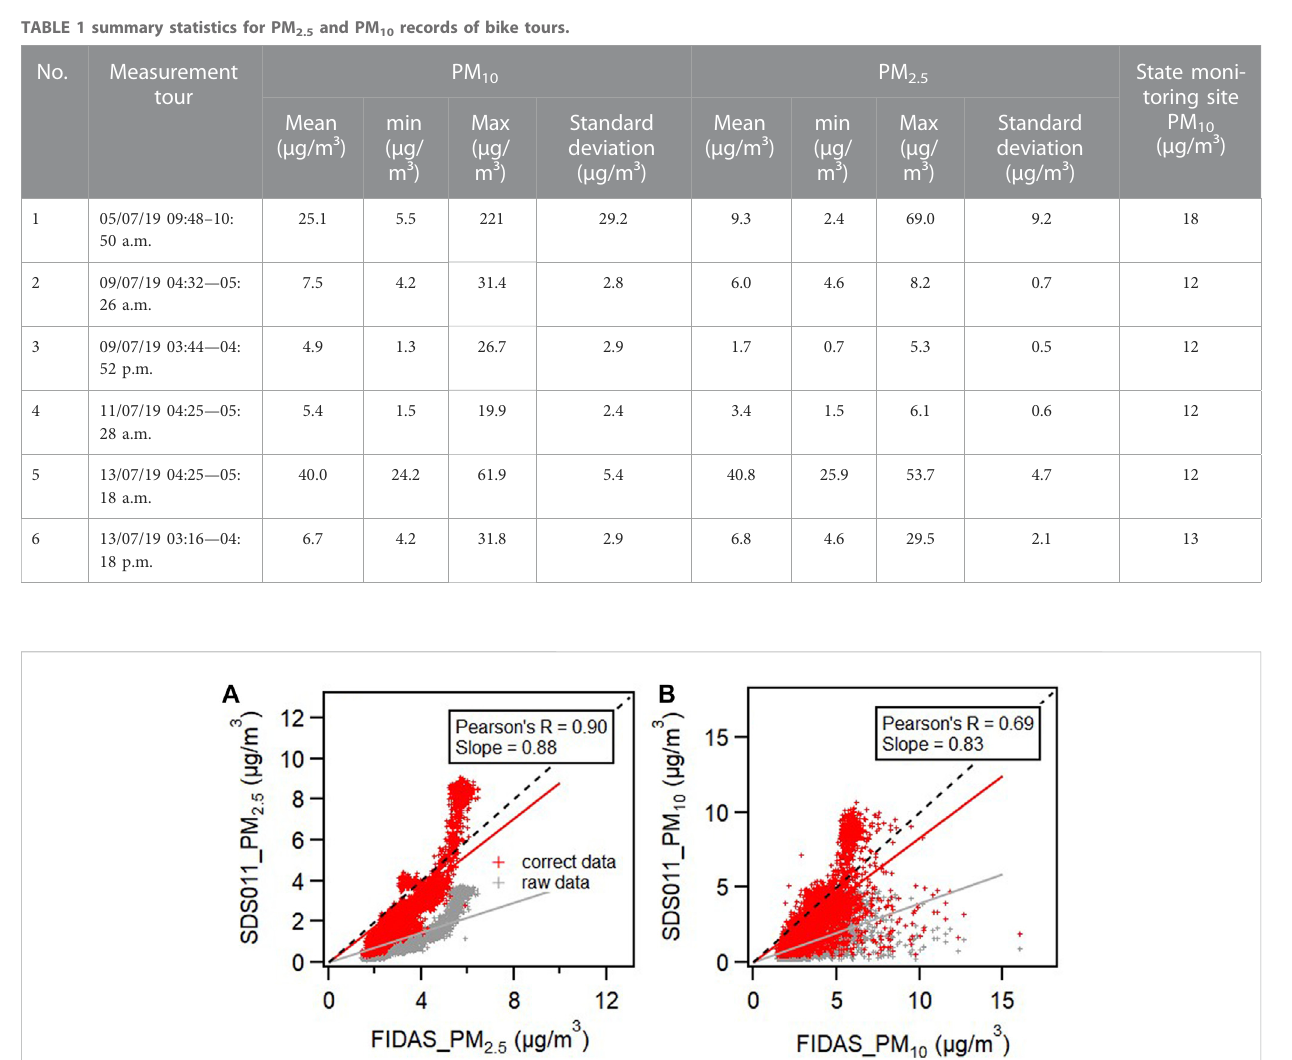
Scatter plots of PM 2.5 (A) and PM 10 (B) mass concentrations measured by SDS011 and FIDAS for calibration issues. The red and grey dots show the data after and before the correction, respectively. The correlation coef fi cients are given for the corrected